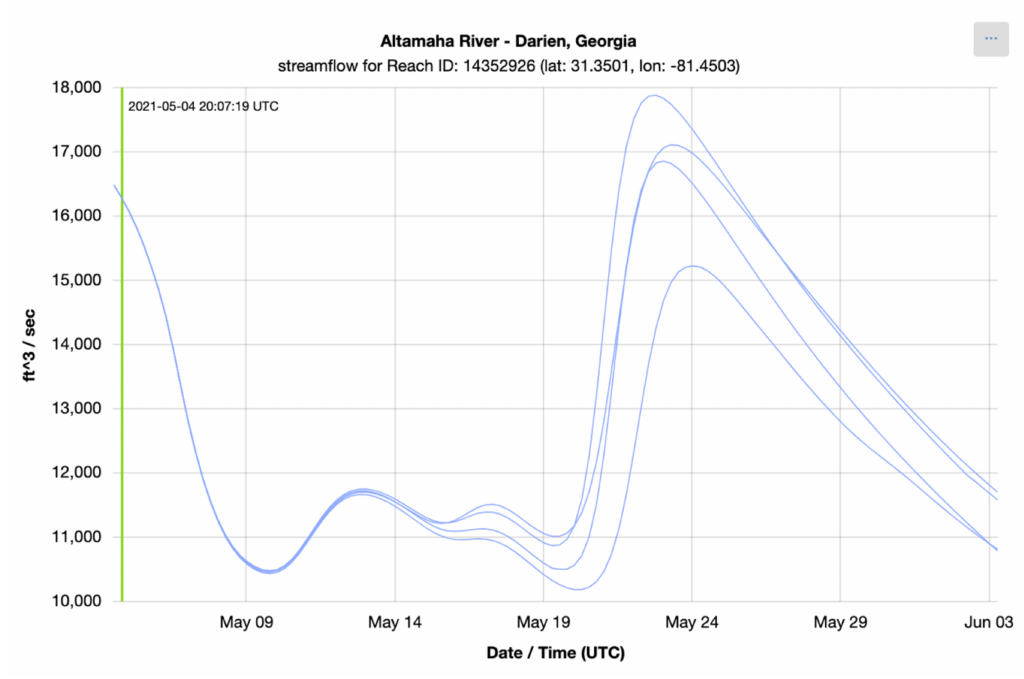
Figure 6. NWM Time Series from NOAA Web App.